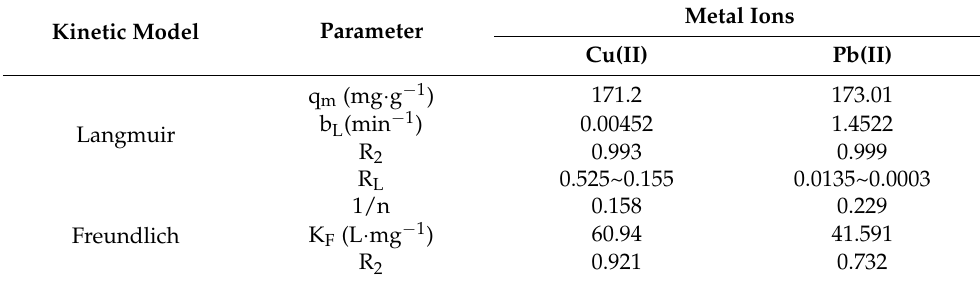
Figure 10. ( a ) Langmuir isotherm; ( b ) Freundlich isotherm (adsorption conditions: Ce (Cu(II)) = 200-2000 mg · L − 1 , V = 10 mL, T = 25 ◦ C, t = 360 min, pH = 5.0, and adsorbent amount = 0.1 g). ( c ) Langmuir isotherm; ( d ) Freundlich isotherm (adsorption conditions: Ce (Pb(II)) = 200-2000mg · L − 1 , V = 10 mL, T = 25 ◦ C, t = 360 min, pH = 5.0, and adsorbent amount = 0.1 g). Table 3. Comparison between Langmuir and Freundlich constants by linear fitting for TA at 25 ◦ C. Kinetic Model